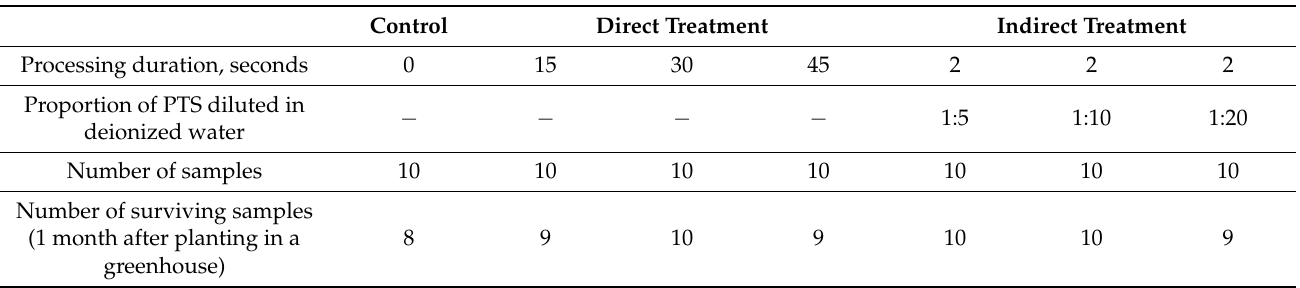
Table 1. Number of samples in experimental groups and number of surviving samples 1 month after planting in a greenhouse.